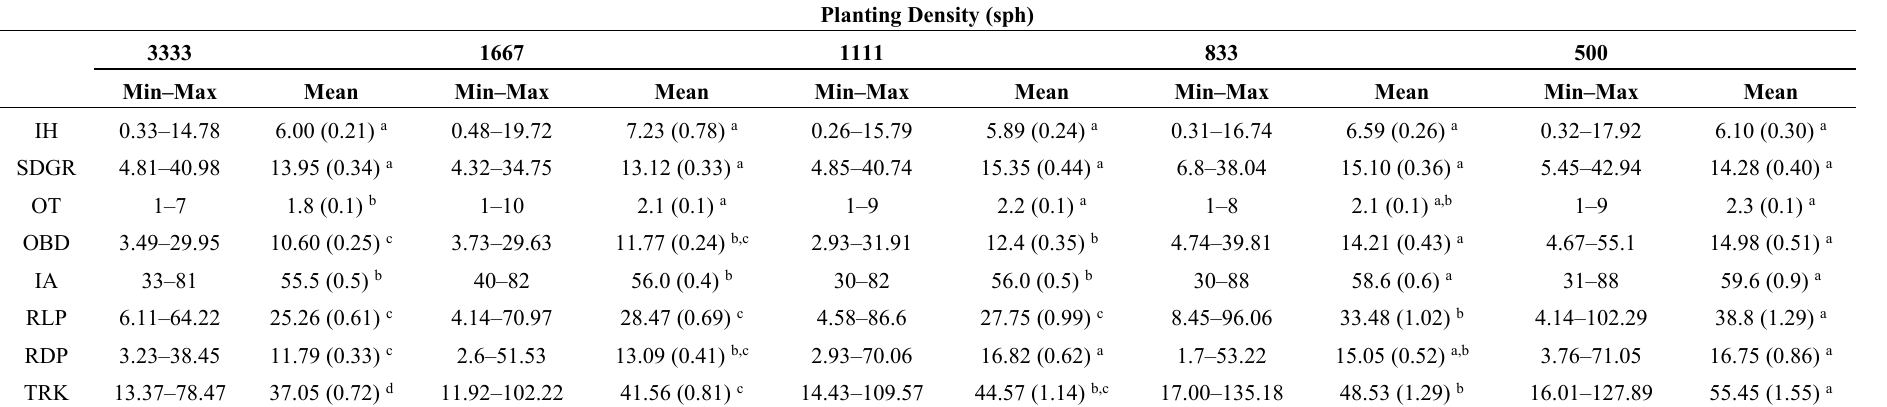
Table 3. Characteristics of knot and branch occlusion of Betula alnoides